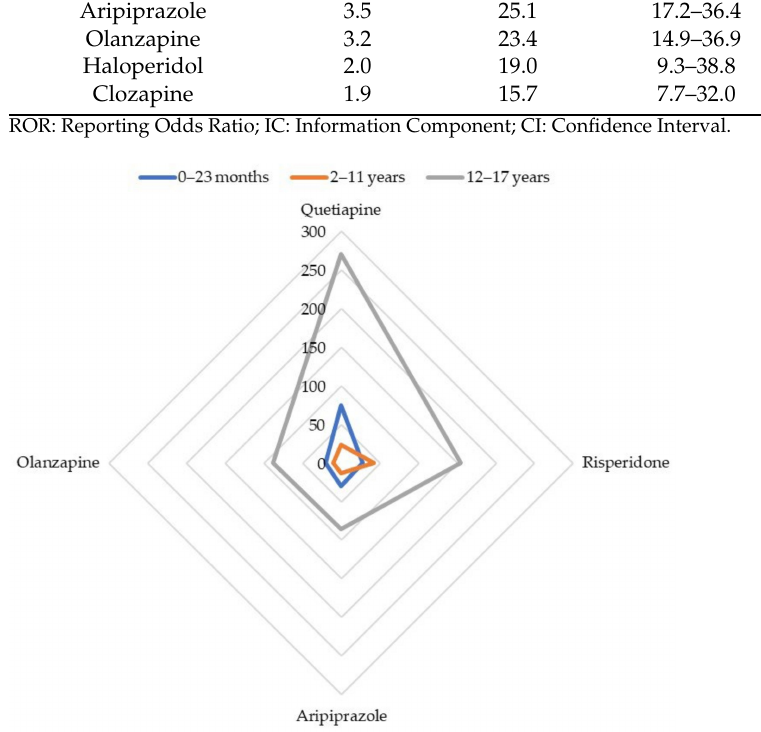
Figure 1. Cases’ distribution for main antipsychotics involved in reports of abuse, dependence, or withdrawal.